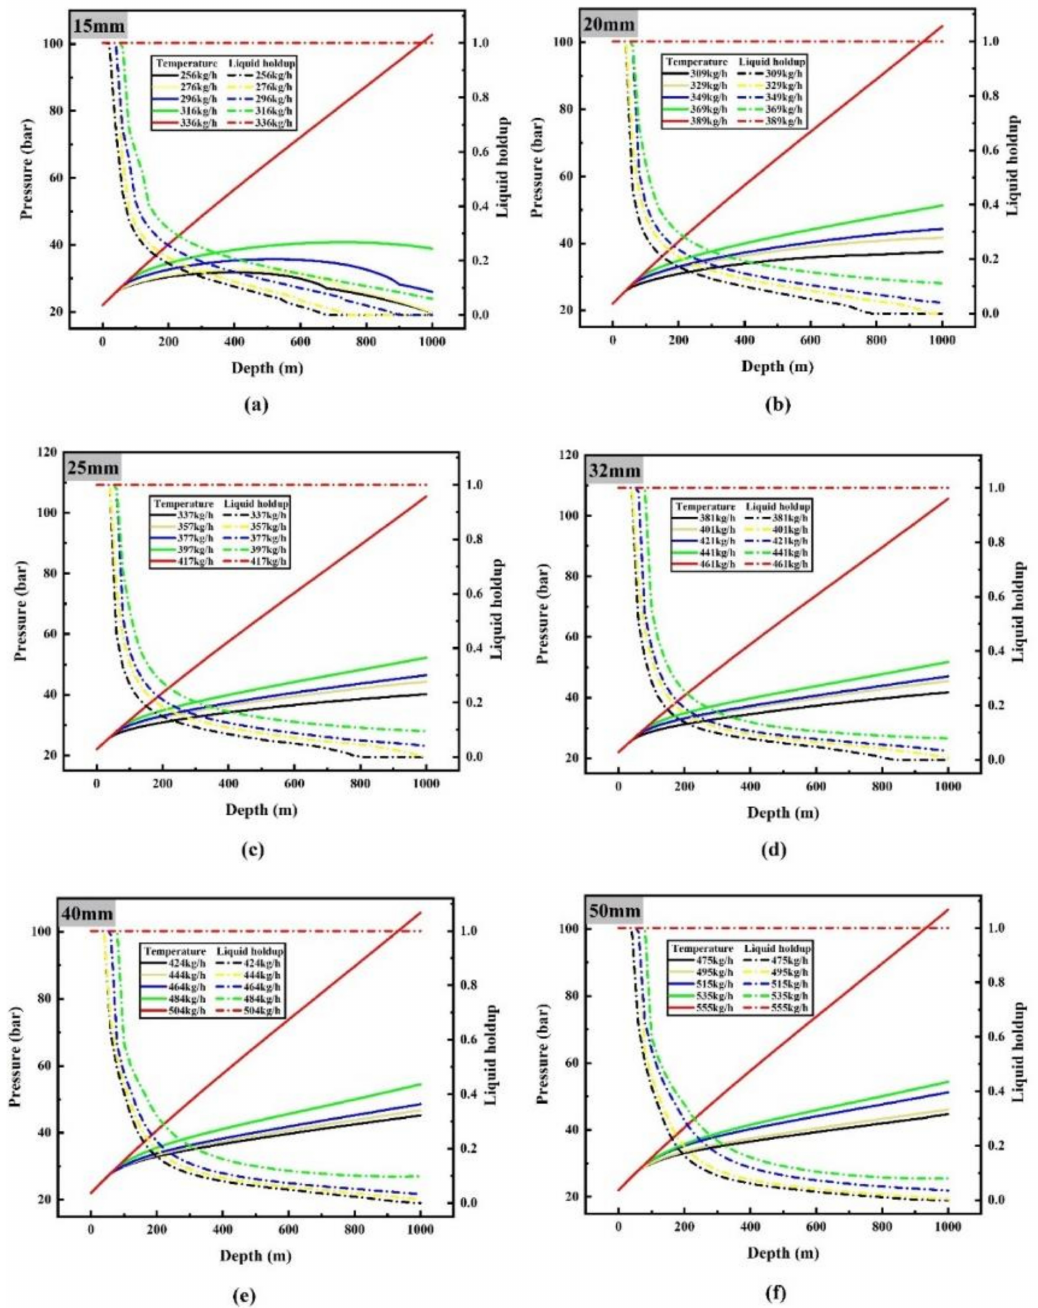
Figure 7. Variations of pressure (solid line) and liquid holdup (dotted line) along the pipeline when the flow rate is less than or equal to the minimum limit flow rate: ( a ) 15 mm diameter; ( b ) 20 mm diameter; ( c ) 25 mm diameter; ( d ) 32 mm diameter; ( e ) 40 mm diameter; ( f ) 50 mm